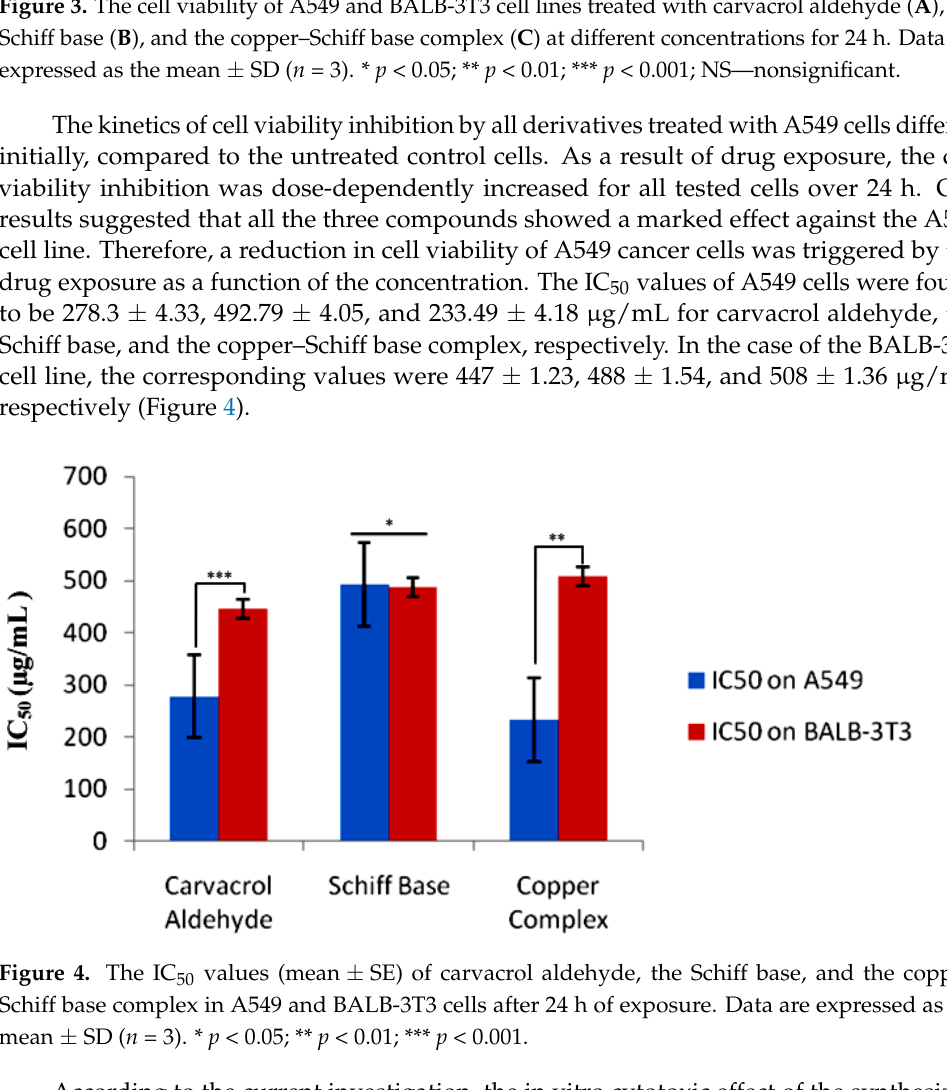
Figure 3. The cell viability of A549 and BALB-3T3 cell lines treated with carvacrol aldehyde ( A ), the Schiff base ( B ), and the copper – Schiff base complex ( C ) at different concentrations for 24 h. Data are